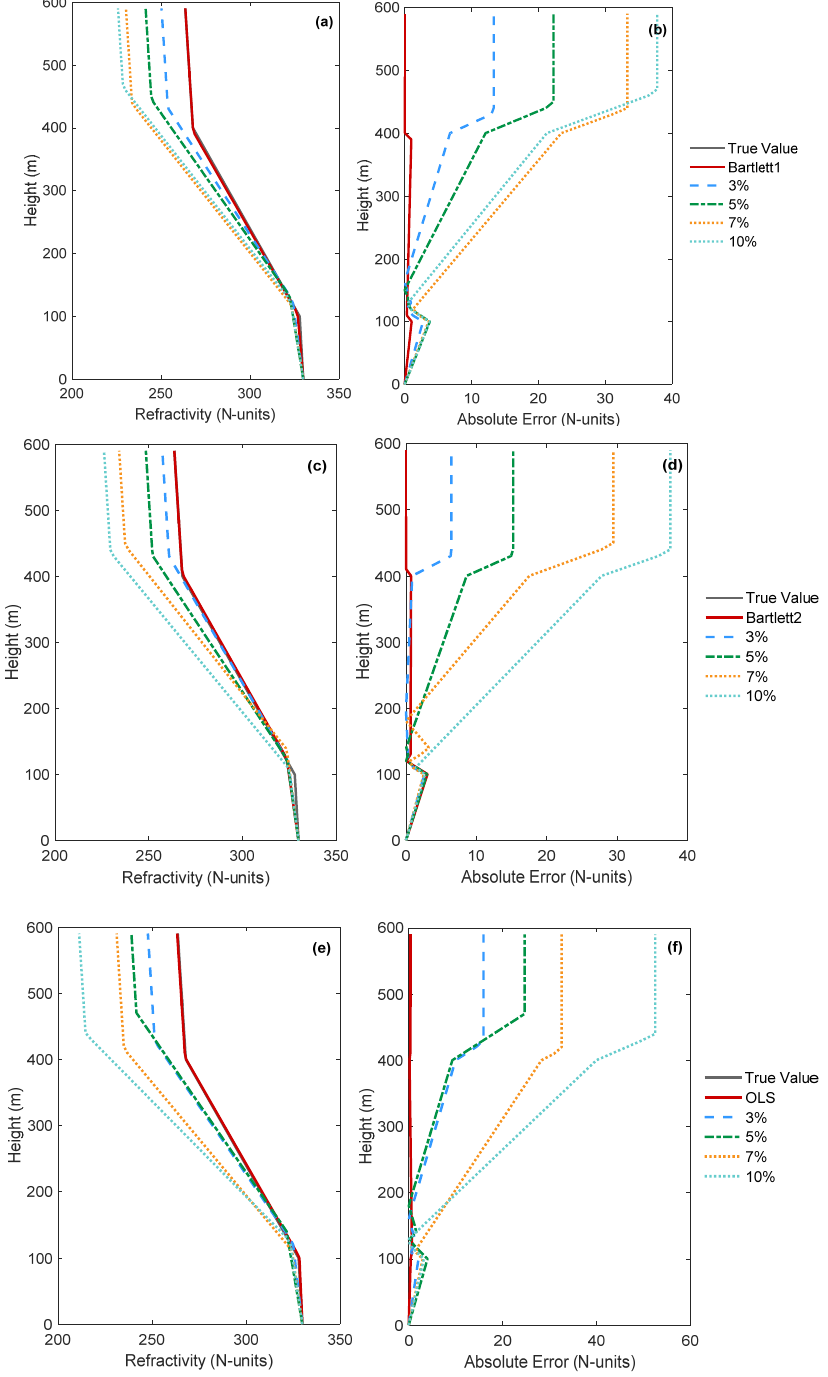
Figure 10. The retrieved refractivity profile and corresponding absolute error by NSSAGA with different objective functions. ( a , b ) The Bartlett objective function with the receiver height information; ( c , d ) the Bartlett objective function without the receiver height information; ( e , f ) the least-squares method with the receiver height